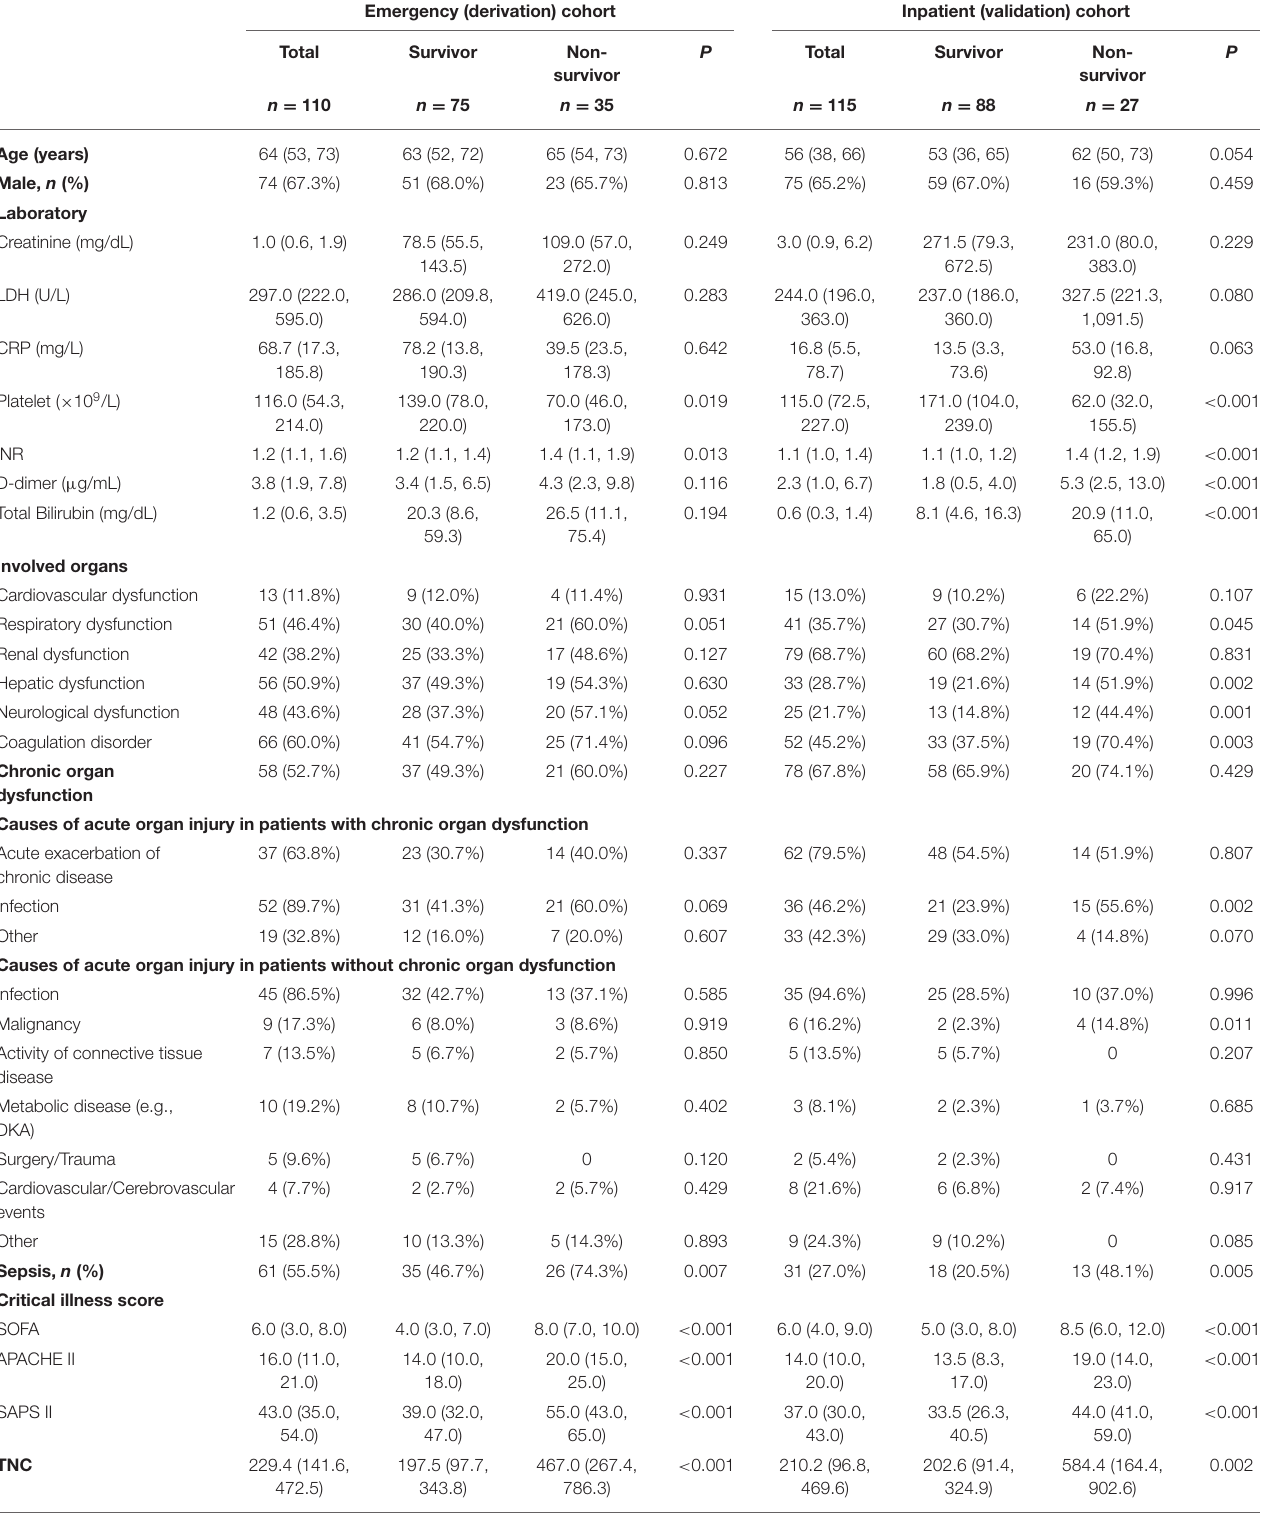
TABLE 1 | Clinical characteristics of patients with multiple organ